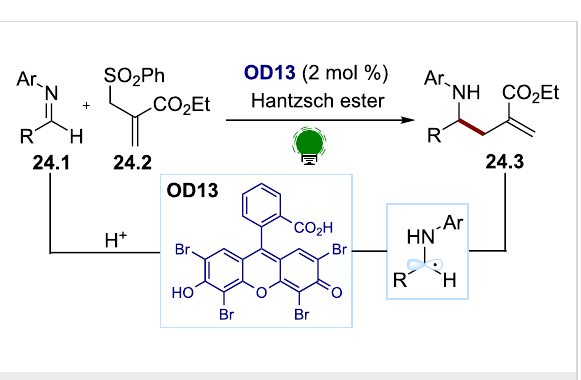
Scheme 24: Illustrative example for the photocatalytic reduction of imines and the generation of an α -amino C(sp 3 ) radical: the umpolung of imines for allylations reported by Dixon and co-workers